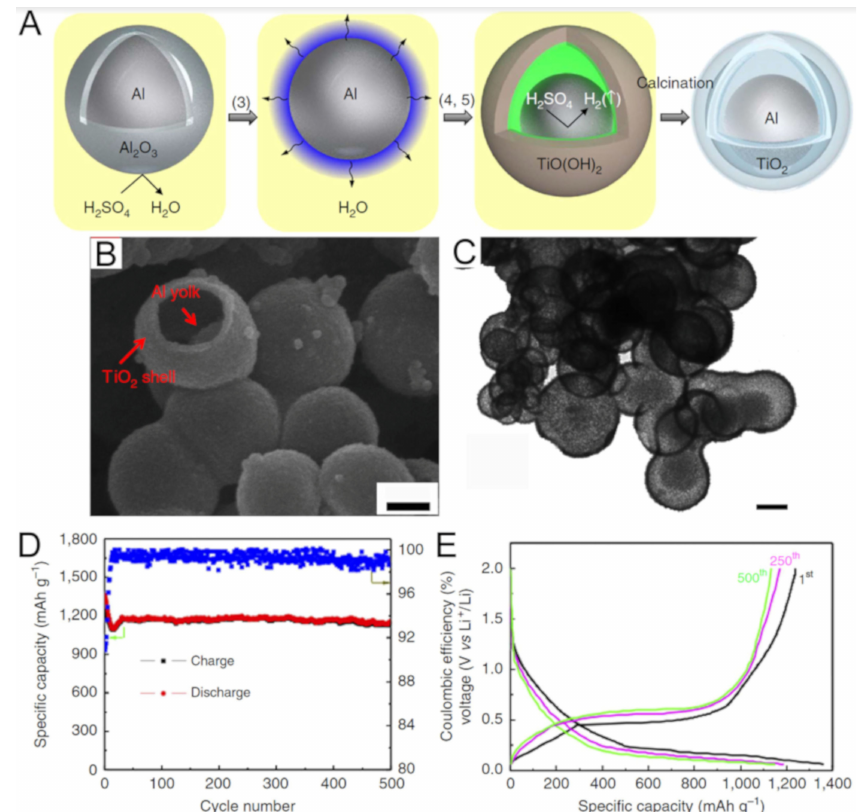
Figure 8. ( A ) Synthetic step of Al@TiO 2 yolk–shell nanospheres. SEM ( B ) and TEM ( C ) images of yolk–shell Al@TiO 2 nanostructures. ( D ) Cycling performance and Coulombic e ffi ciency at 1 C rate. Scale bars are 20 nm ( B ) and 10 nm ( C ). ( E ) Charge–discharge profile of the first, 250 th , and 500 th cycling. Reproduced with permission from [77]. Copyright Springer Nature Publishers Ltd,